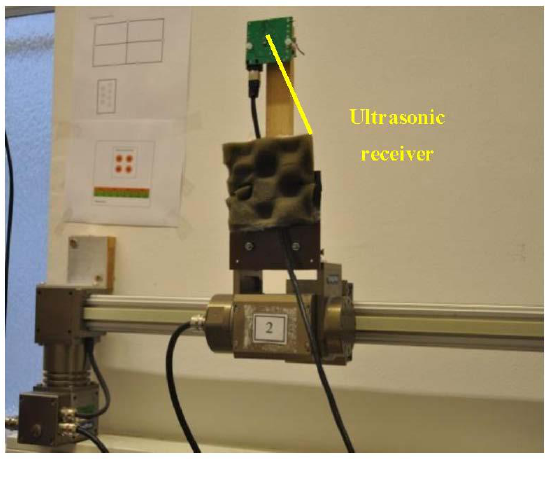
Figure 13. Receiver unit mounted on moving